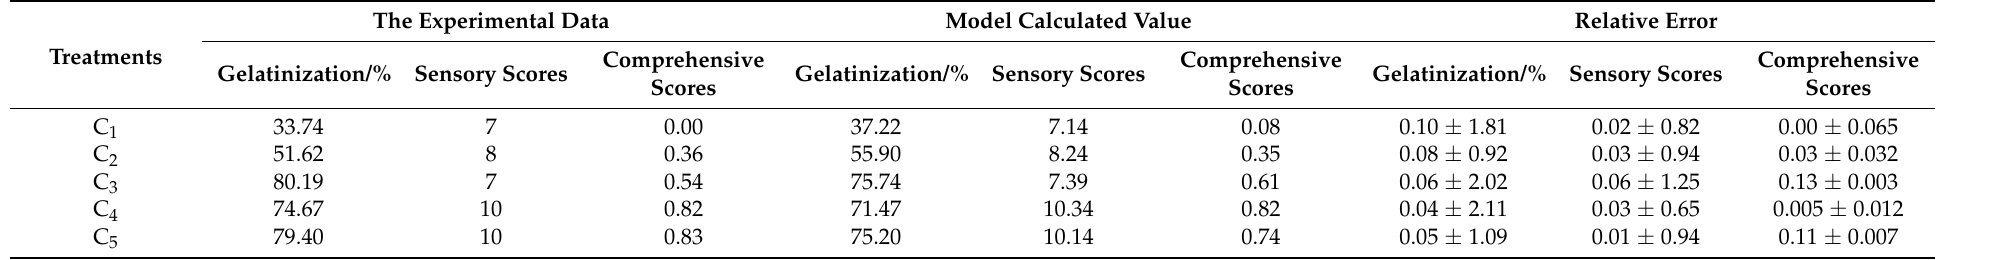
Table 4. Comparison of experimental data and model calculated